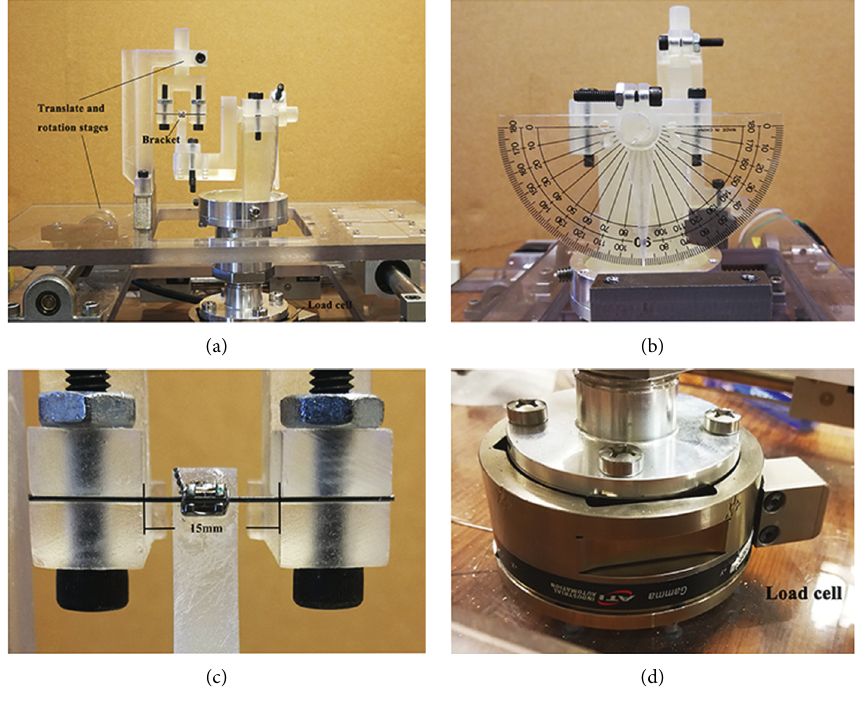
Figure 3: The torque measurement device.